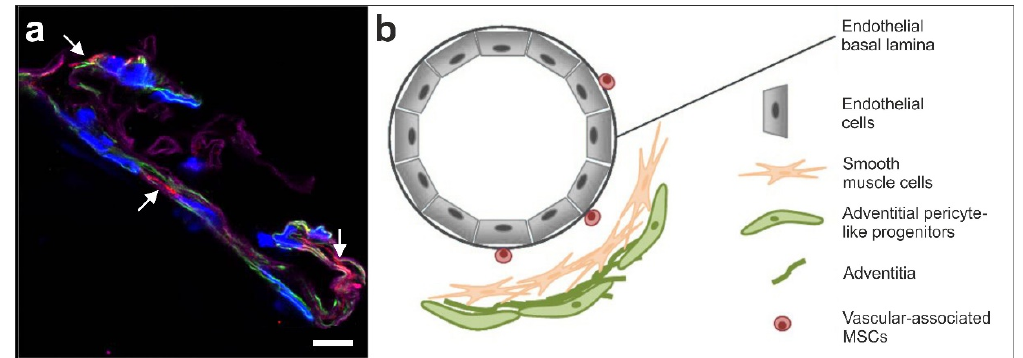
Figure 1. ( a ) Immunofluorescent detection of NG2 (red; arrows), smooth muscle antigen (SMA) (green) and laminin (purple) in the wall of a small arteriole; cell nuclei are in blue (modified from [3]). The scale bar represents 10 µm. ( b ) Schematic illustration of the hypothesized location of vascular associated MSCs (taken from [3] and modified from [35]).